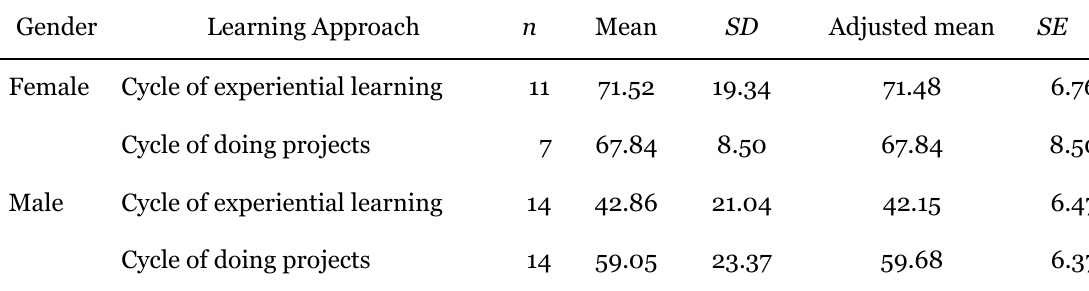
Simple Main-Effect Analysis Based on the Division of Gender